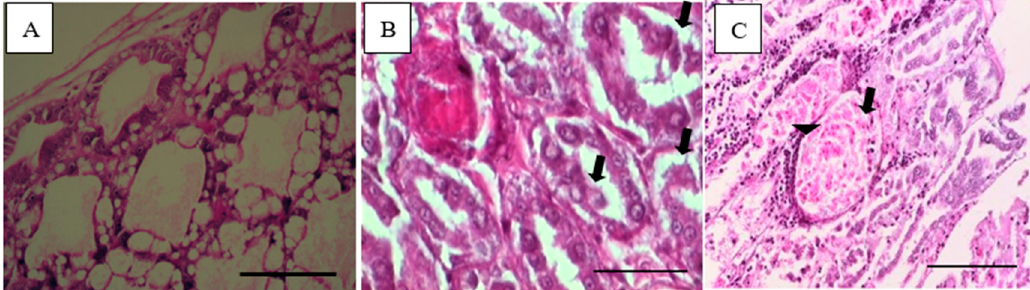
Figure 2. Histopathology of shrimp hepatopancreas (HP). Unchallenged shrimp showed normal structure of shrimp HP ( A ). Challenged shrimp showed sloughing of HP tubule epithelial cells (( B ), arrows), sloughing and necrosis of tubule epithelial cells (( C ), arrow) and hemocytic infiltration surrounding HP tubules (( C ), arrowhead). H&E stain. Magnification 400X. Scale bars = 50 µm.